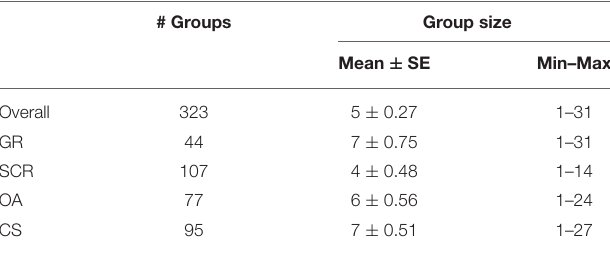
TABLE 1 | Number of groups and group size (mean ± SE, minimum and maximum) by geographic